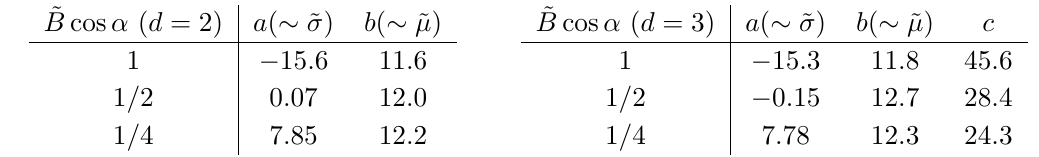
c , B = B c and B ≤ B c ,